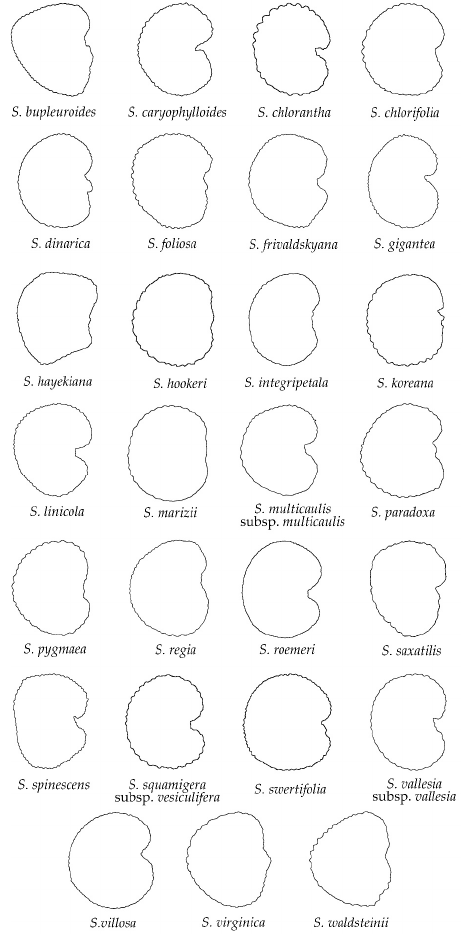
Figure 3. Silhouettes of lateral views of seeds in the group of rugose outline.